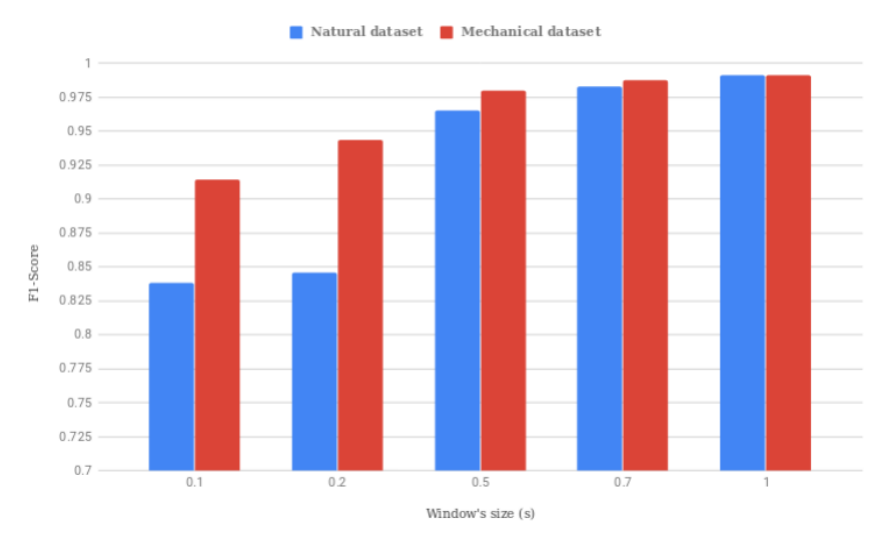
Figure 12. Evaluation of the natural (blue) and the mechanical (red) datasets of the approach GPLVM + SVM without optimization and 10 latent variables. The mechanical data need less force information to classify with good quality. However, if the window of the force signal is large enough (more than 0.5 s), the model behaves similarly no matter whether the data are mechanical or